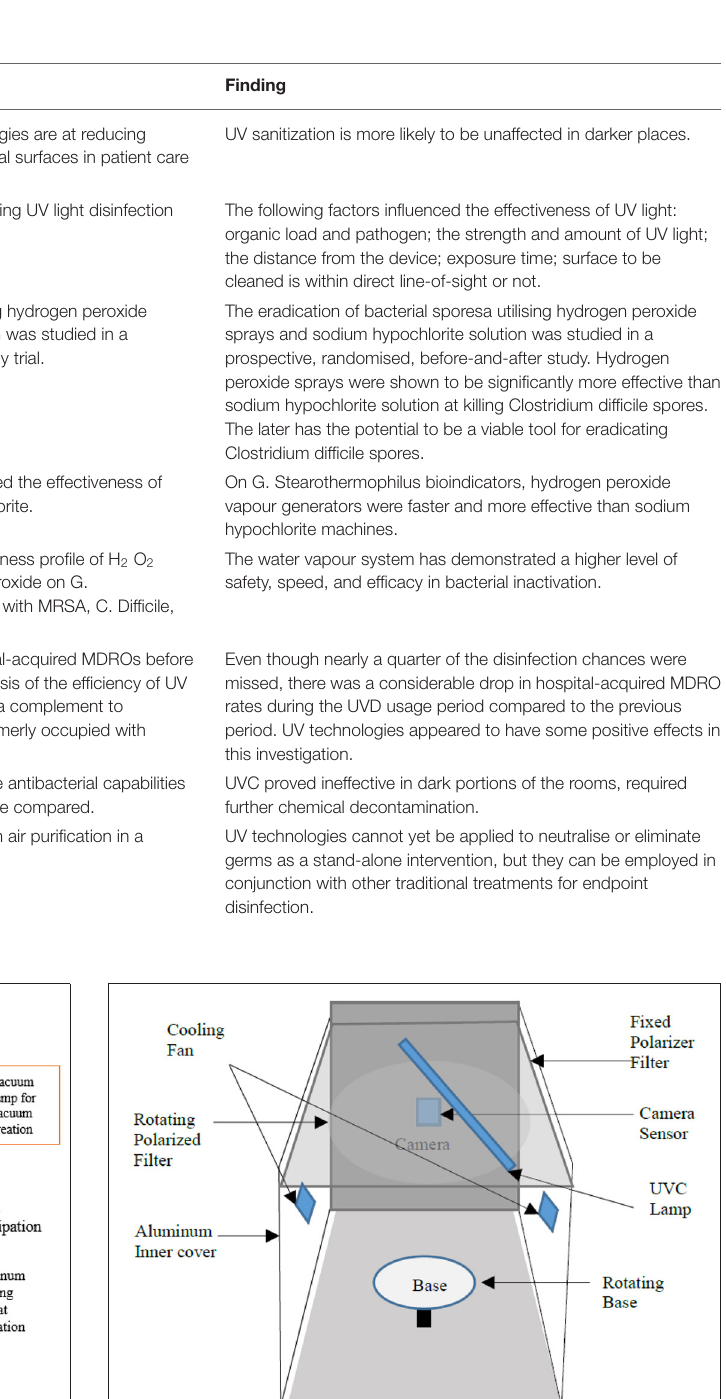
distribution of the UVC rays to the object which is placed